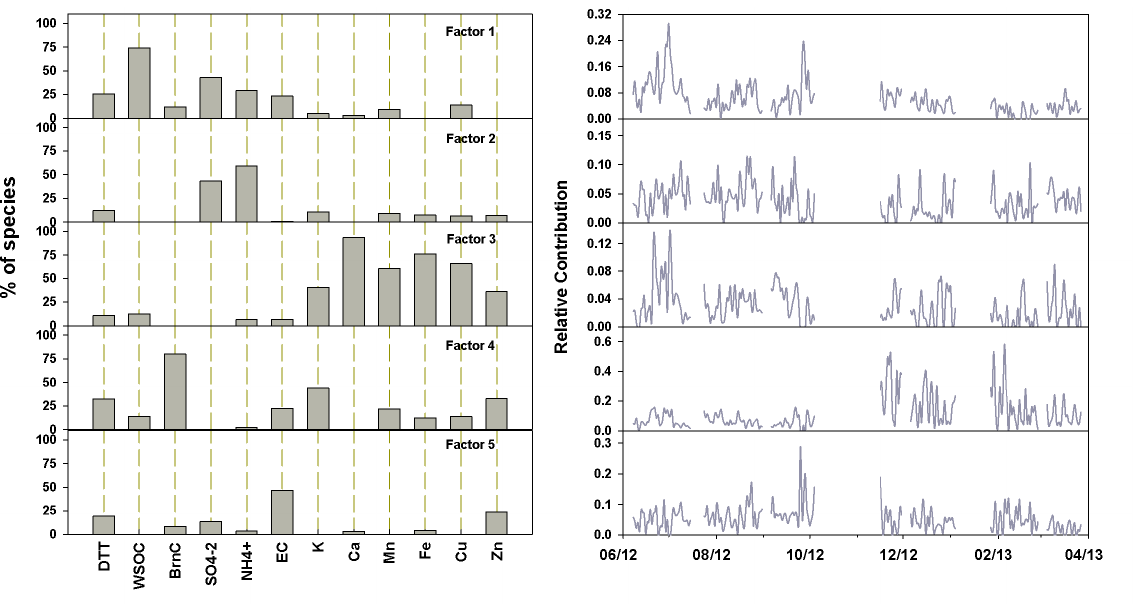
Figure 6. Composition profiles (percentage of each species) for the five factors resolved by PMF (left panel), and the time series of their relative contribution (right panel).